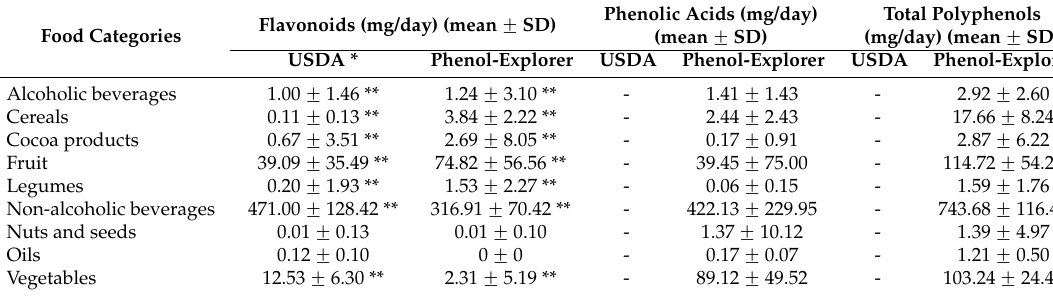
Table 3. Contributions of food categories to flavonoid, phenolic acid and total polyphenol intakes (mg/day) ( n =